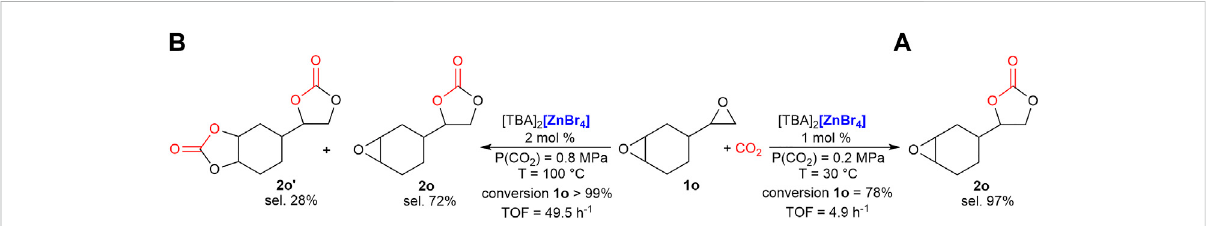
SCHEME 1 Selective synthesis of mono (A ) and di-cyclic carbonates (B) of 4-vinylcyclohexene dioxide, 1 ° . Reaction conditions: epoxide 250 μ l (1.94 mmol); cat. 1 or 2 mol%. Conversion and selectivity determined by 1 H NMR using mesitylene as the internal standard. Turnover frequency (mol 1o (converted) · mol cat − 1 · reaction time − 1 ).